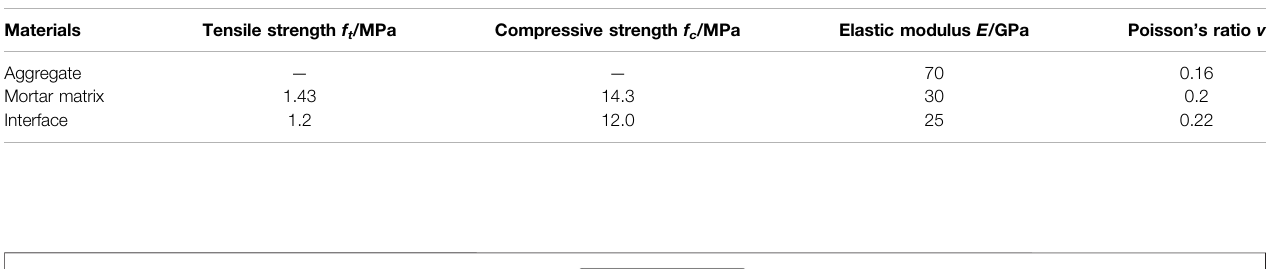
TABLE 2 | Mechanical parameters of concrete micro-component materials.